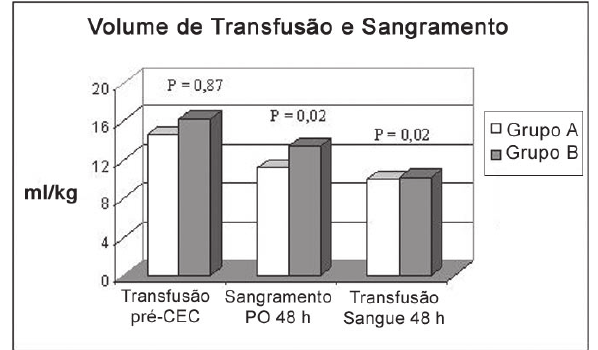
Fig.3 - Comparação entre os grupos A e B com relação à necessidade de transfusão de concentrado de hemácias antes da circulação extracorpórea (CEC), sangramento no pós-operatório (PO) e necessidade de transfusão após o procedimento cirúrgico